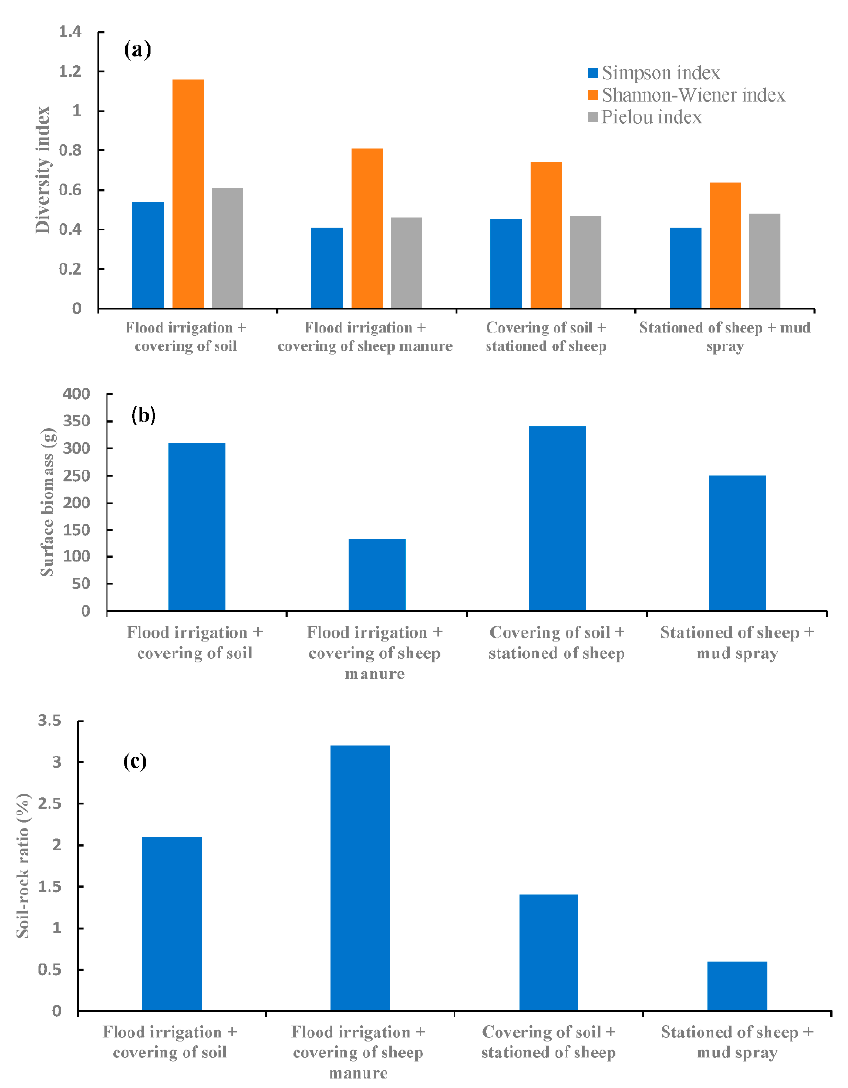
Figure 8. Effects of combinations of various measures on vegetation and soil. Note: ( a – c ) are subtitle of Figure. ( a ) is diversity index, ( b ) is surface biomass and ( c ) is soil-rock ratio